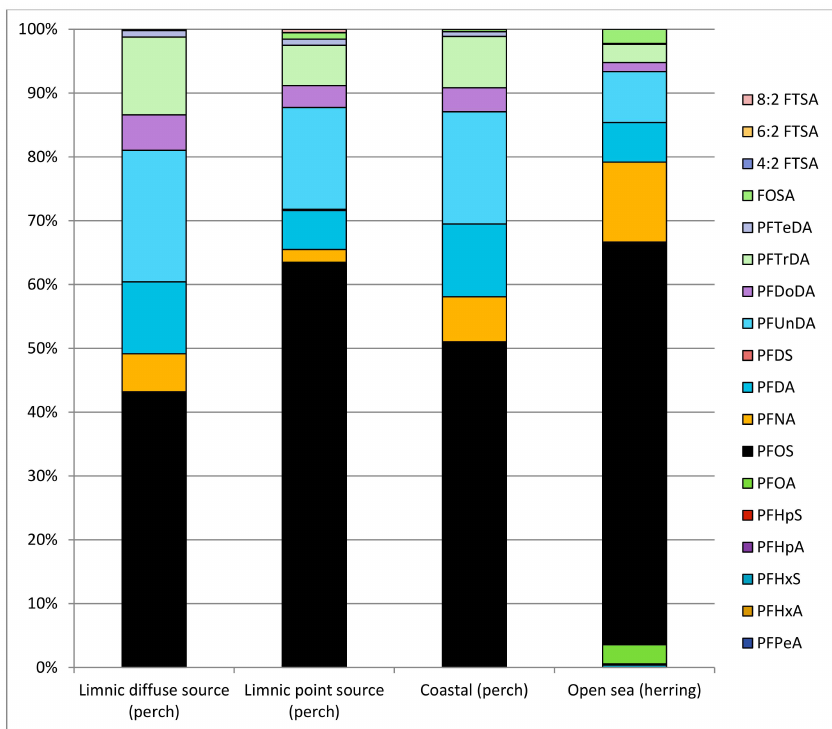
Figure 6. PFAS profiles based on mean concentrations of individual PFASs in fish from di ff erent types of sampling